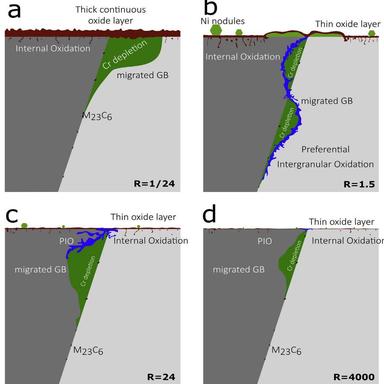
Schematics highlighting the evolution of PIO, DIGM, the external oxide layer and internal oxidation region as a function of the oxidizing conditions: a) R 1.